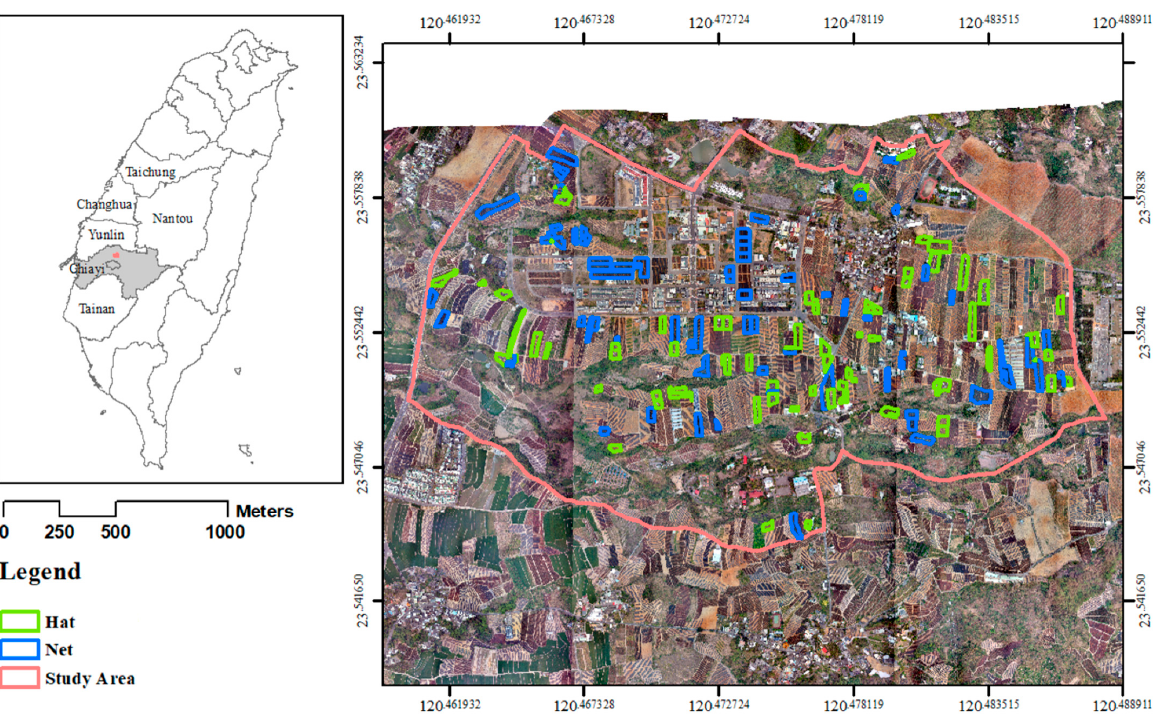
Figure 10. The interpretation results of pineapple fields wearing a hat and covered with nets. Table 7. The data used for production estimation.